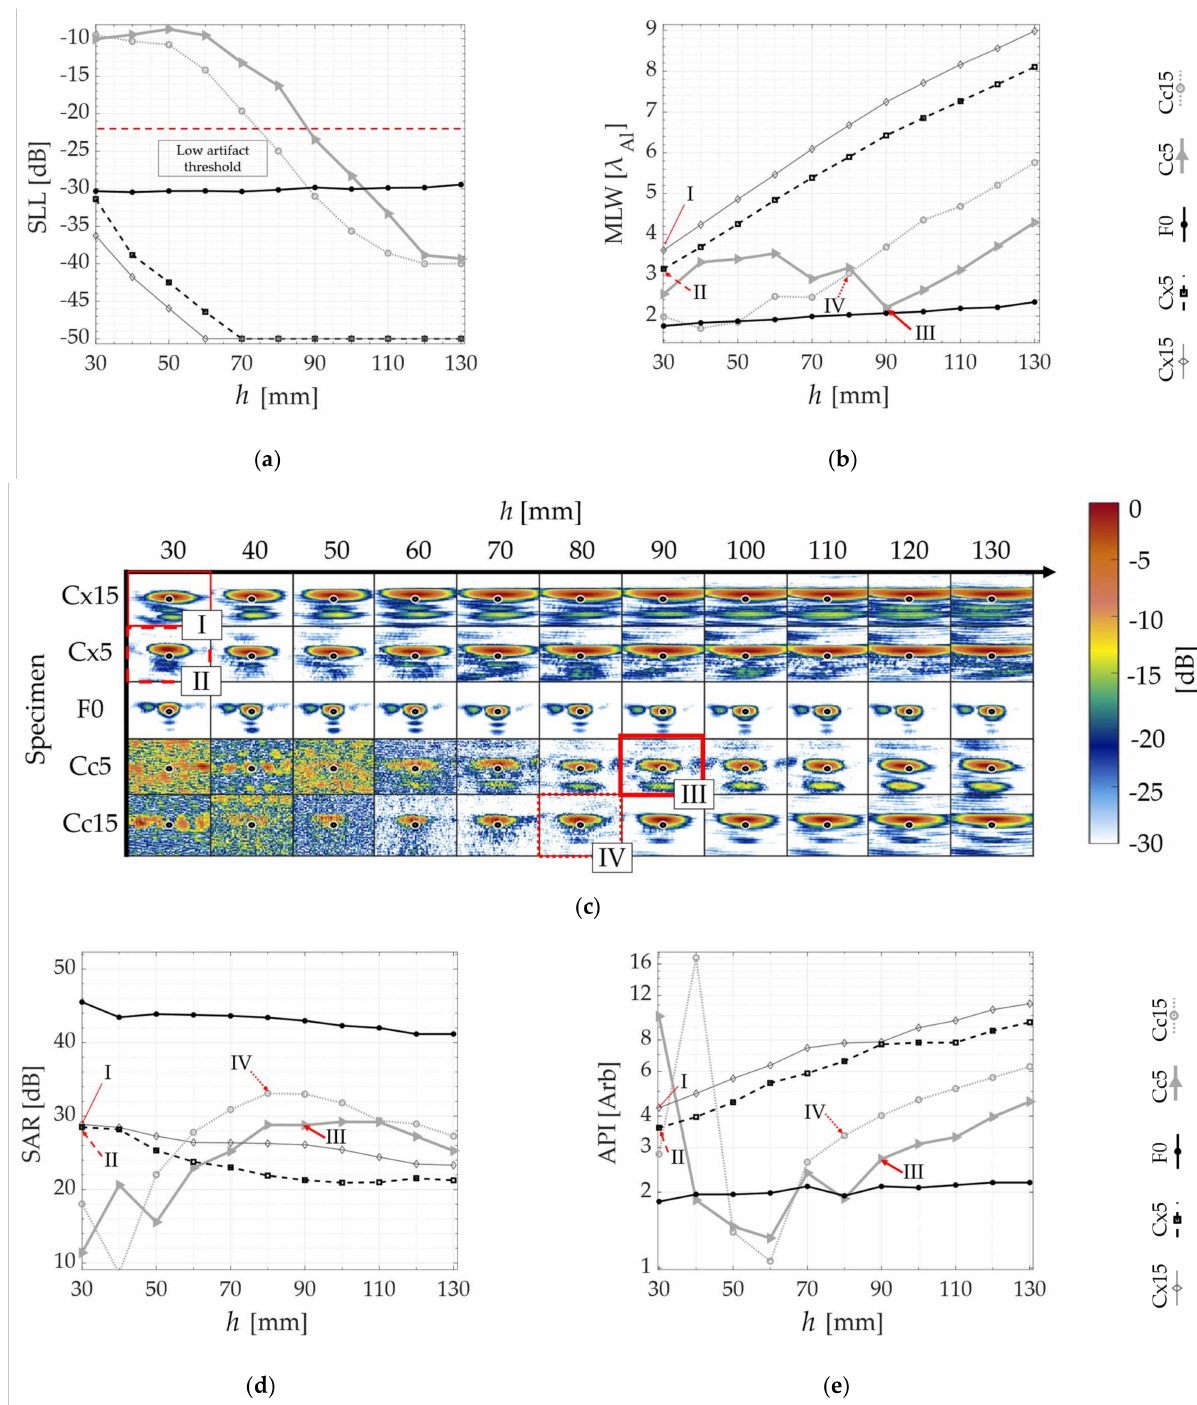
Figure 9. PSOM and experimental results from the SDH at 70 mm depth inside each specimen: ( a ) SLL obtained from PSF ( x ) at each standoff h ; ( b ) MLW vs. h ; ( c ) TFM images at different probe standoffs h in each of the five specimens; ( d ) SAR vs. standoff; ( e ) API vs. standoff. The numbers I, II, III and IV indicate the optimal probe standoffs selected by the